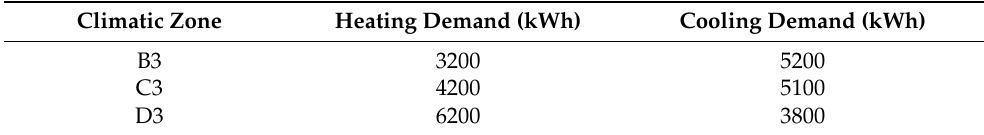
Table 2. Average annual energy demands for the residential sector in the Region of Murcia for